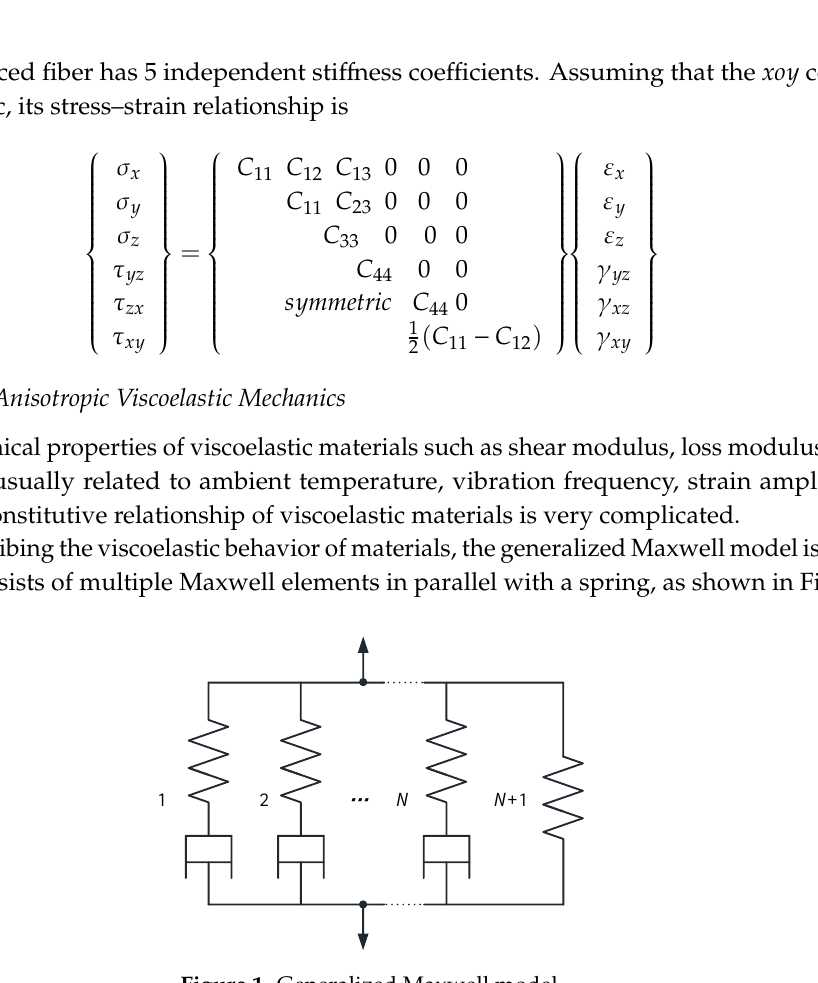
Figure 1. Generalized Maxwell model.